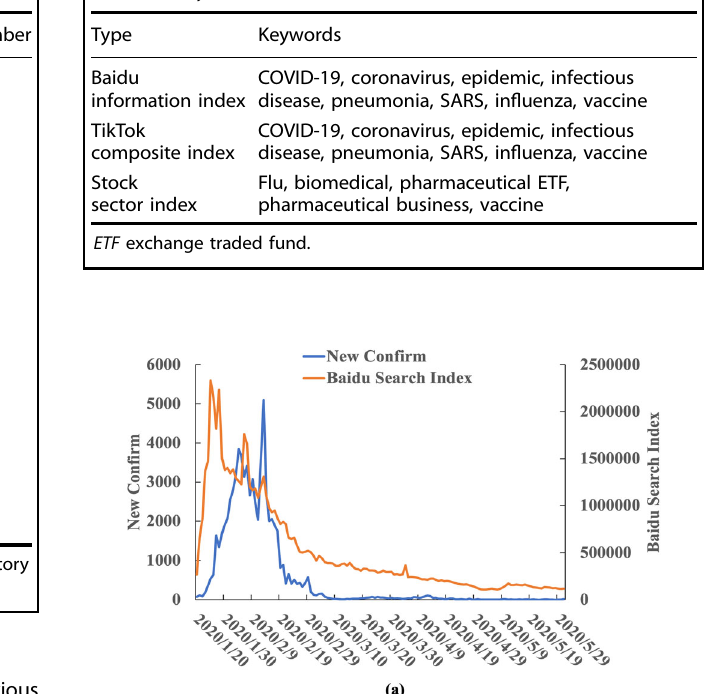
Table 7. Keyword list of the Baidu search index. Table 8. Keyword list for online media data.